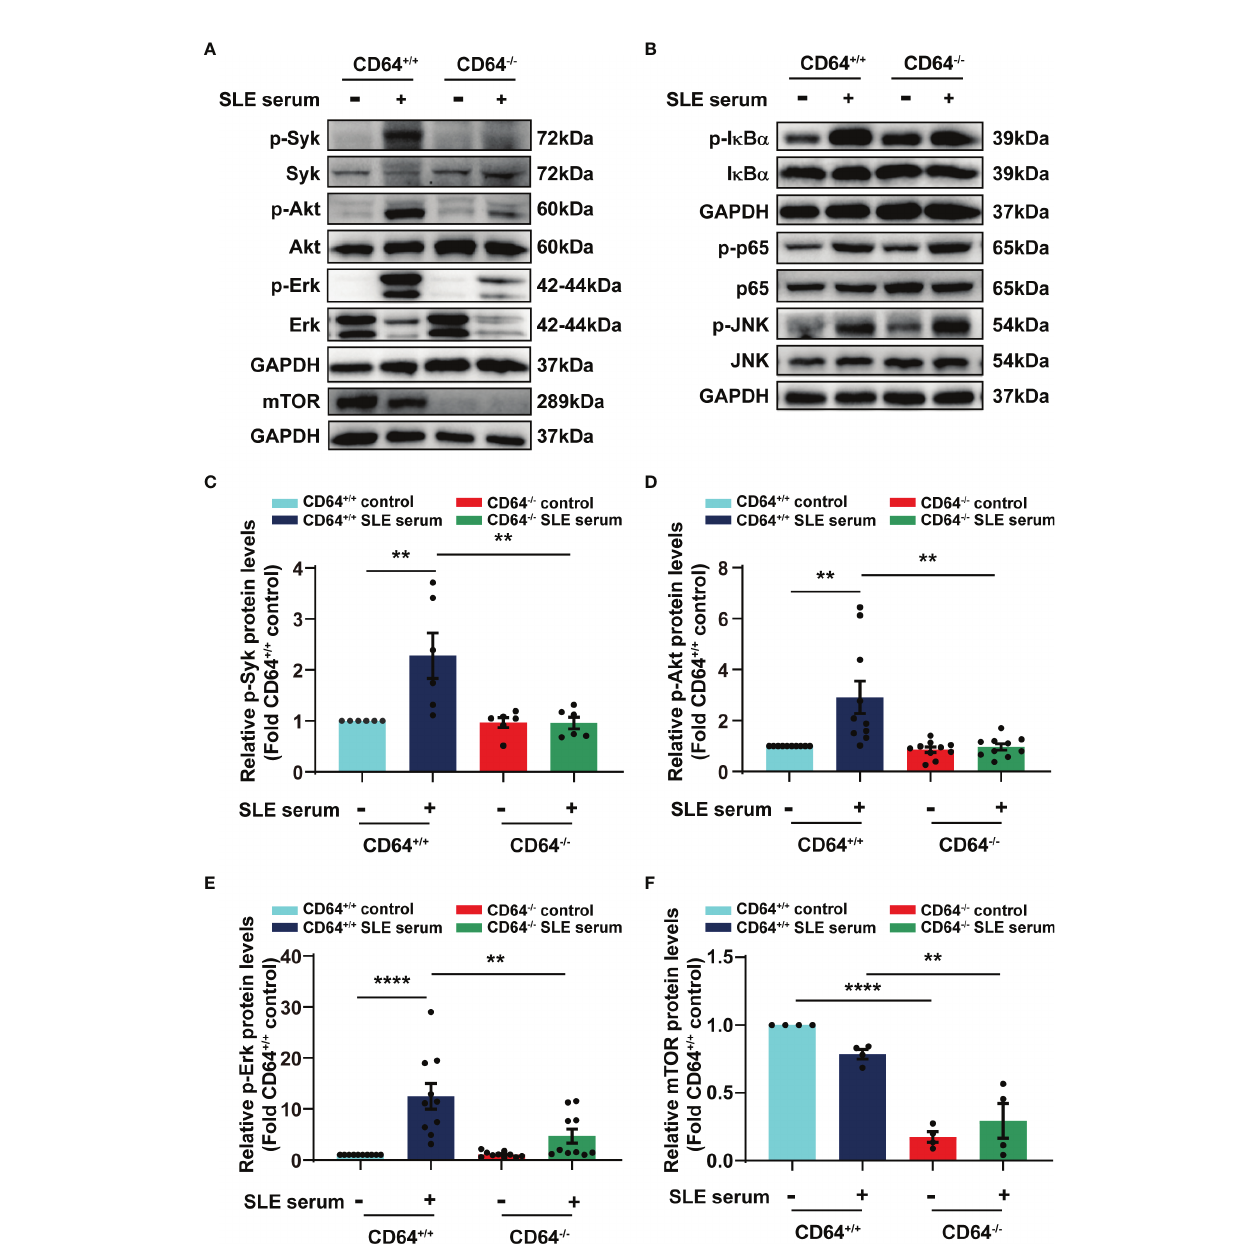
FIGURE 6 | SLE serum promoted in fl ammation through CD64/Syk/Akt/Erk signaling pathway in macrophages. Bone marrow-derived macrophages (BMMs) were isolated from CD64 wild ( +/+ ) and CD64 de fi cient ( -/- ) mice. Western blot identi fi ed protein levels in BMMs stimulated with 20 m L SLE serum or normal saline for 2 h. (A) Representative picture of phosphorylated Syk (p-Syk) and total Syk, phosphorylated Akt (p-Akt) and total Akt, phosphorylated Erk (p-Erk) and total Erk, and mTOR protein levels measured by Western blot. (B) Western blot identi fi ed phosphorylated I k B a (p- I k B a ) and total I k B a , phosphorylated p65 (p-p65) and total p65, phosphorylated JNK (p-JNK) and total JNK in BMMs. (C – F) Bar graphs depicting the changes in the relative expression of p-Syk (C) , p-Akt (D) , p-Erk (E) and mTOR (F) . ** p < 0.01, **** p <